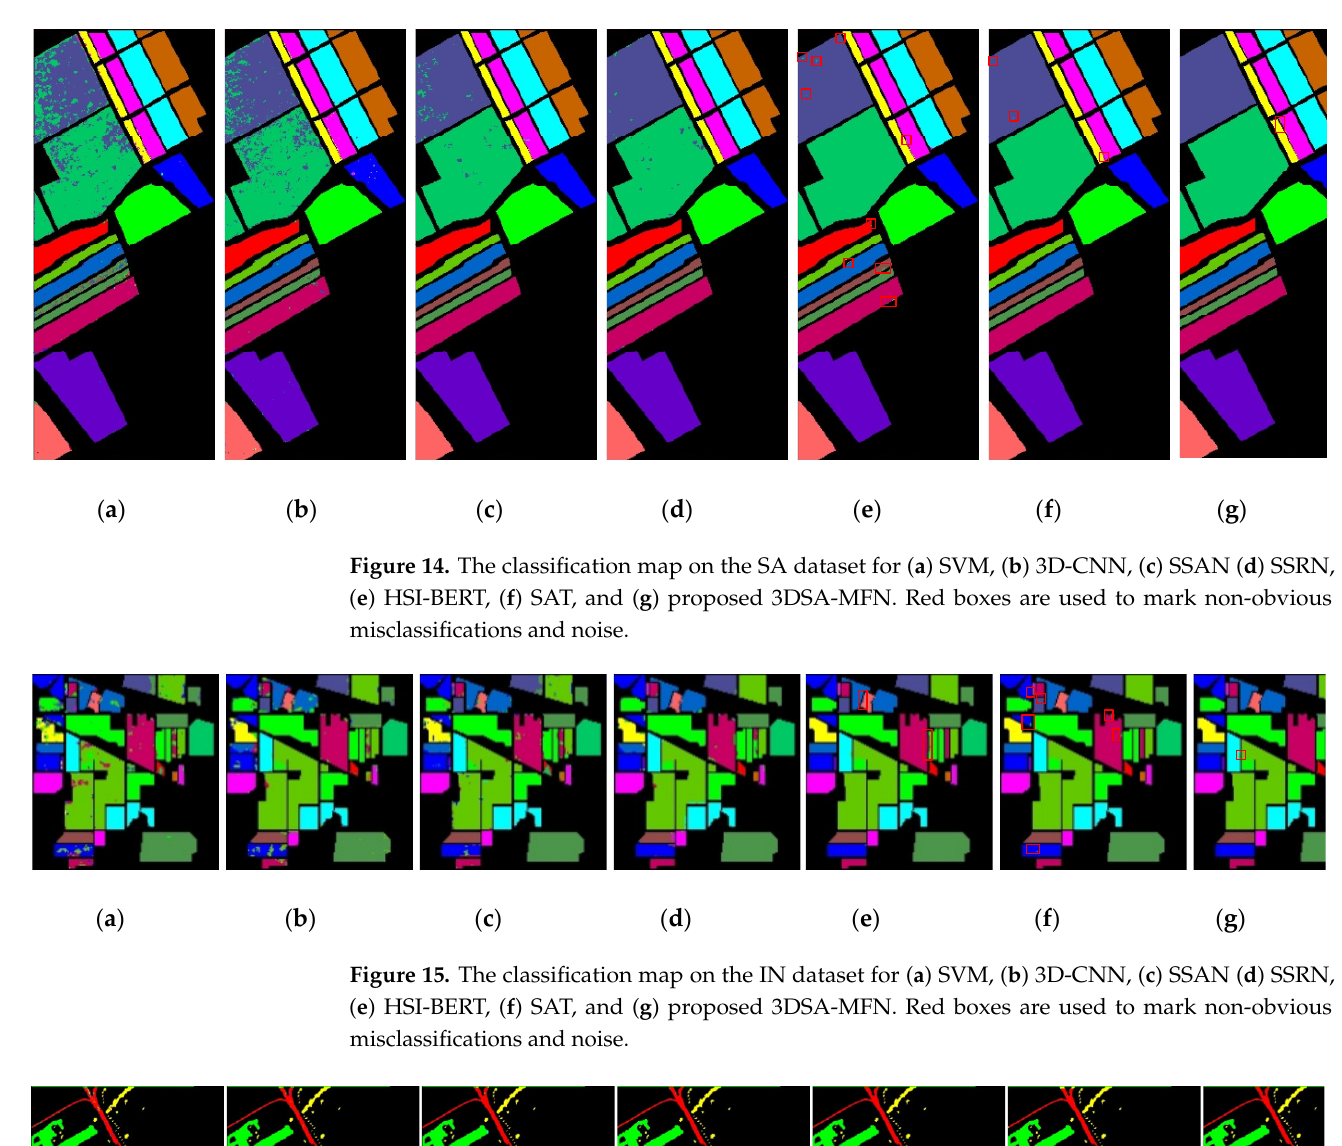
18 of 23 Figure 12. Overall accuracy curve of different models in IN dataset.